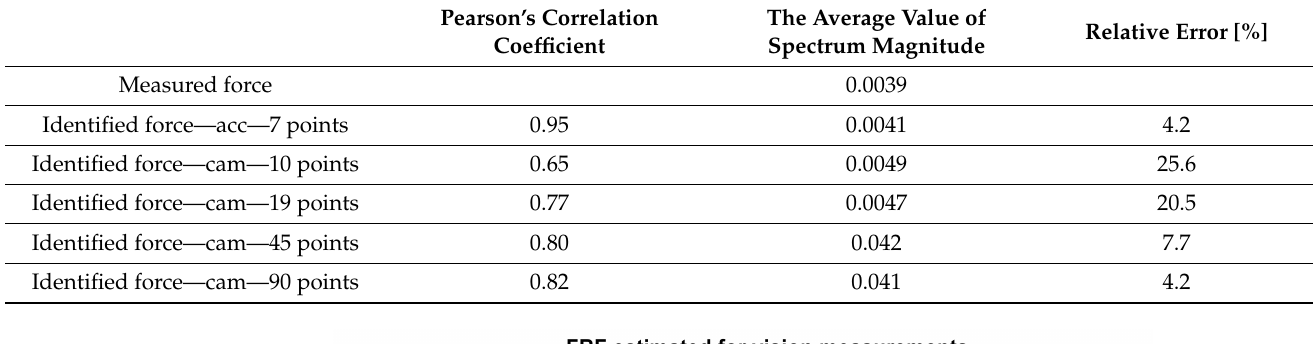
Table 2. Quantitative assessment of the identification of forces.